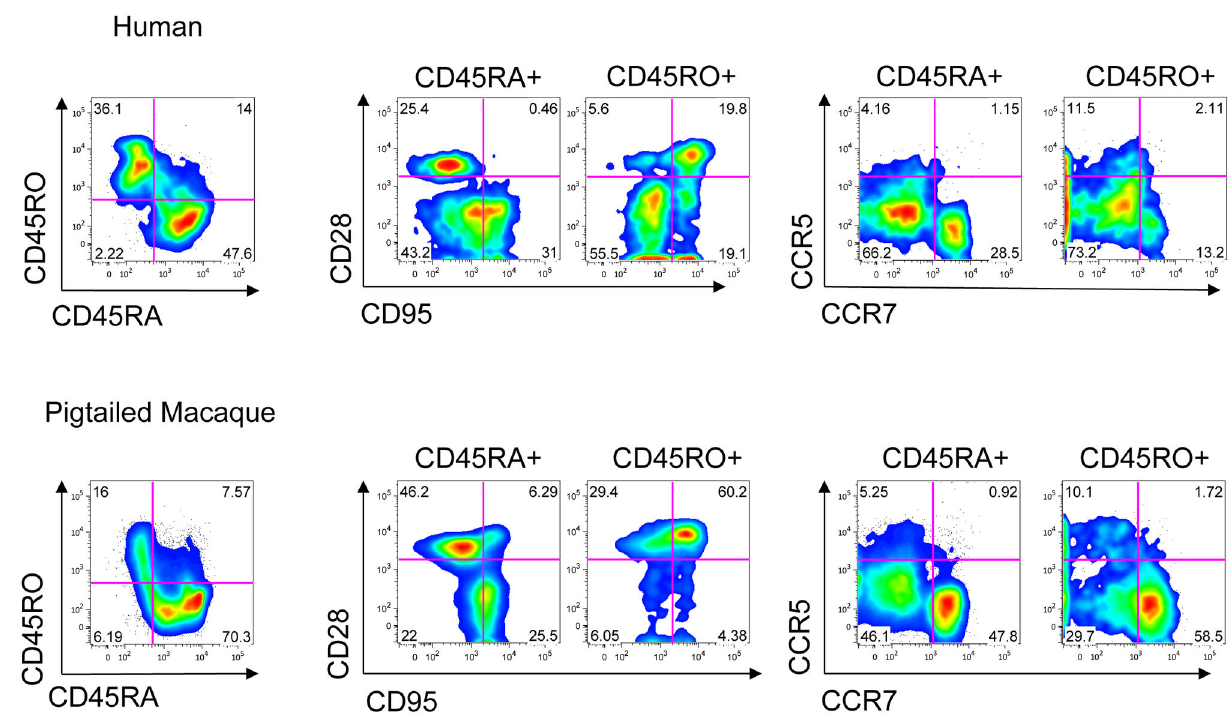
Figure 4. Memory markers on PBMC. Cryopreserved PBMC from an uninfected pigtailed macaque and a human were stained with panels of Abs to memory markers (CD45RO, CD45RA, CD95, CD28 or CD45RO, CD45RA, CCR7, CCR5). Cells were gated on singlets and lymphocytes by light scatter, and then gated on single-positive CD45RO or CD45RA. Human cells are displayed in the top row and macaque cells in the bottom row. Left: CD45RO and CD45RA expression on lymphocytes, showing gates used to distinguish CD45RO+ and CD45RA+ cells in center and right panels. Center: CD95 and CD28 expression on CD45RO and CD45RA single-positive cells. Right: CCR7 and CCR5 expression CD45RO and CD45RA single-positive cells. Data are from a single